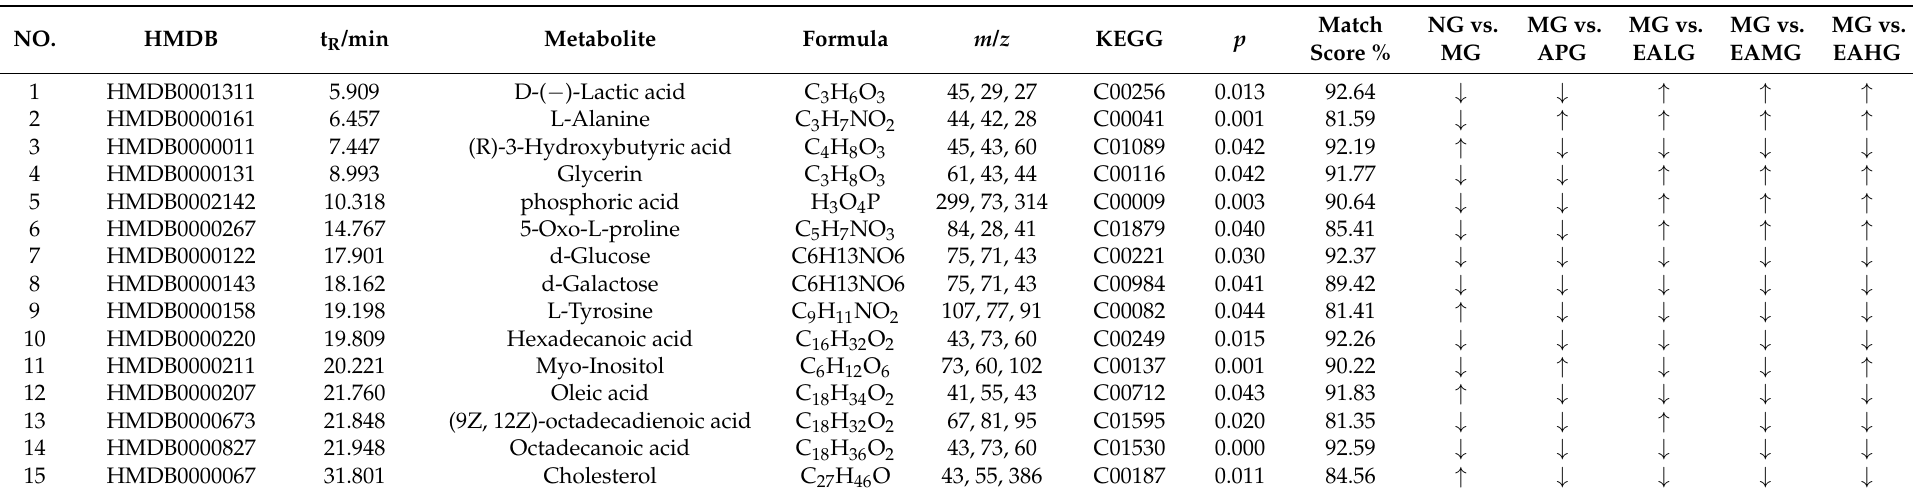
Table 1. The information and changing trend of potential biomarkers in six